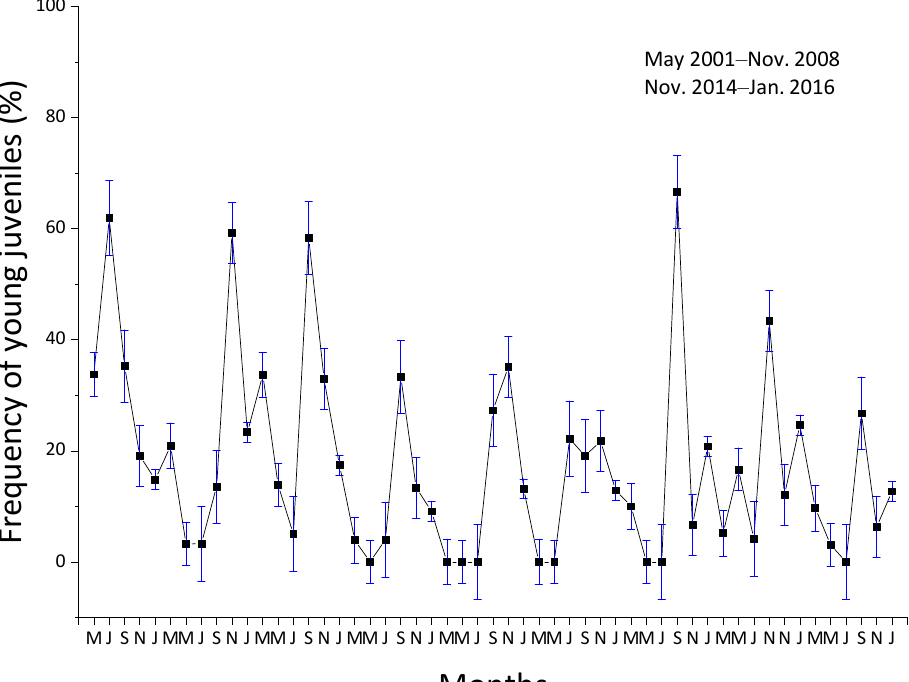
Figure 7. Seasonal changes of young juveniles during the sampling periods (bar = ± SD).